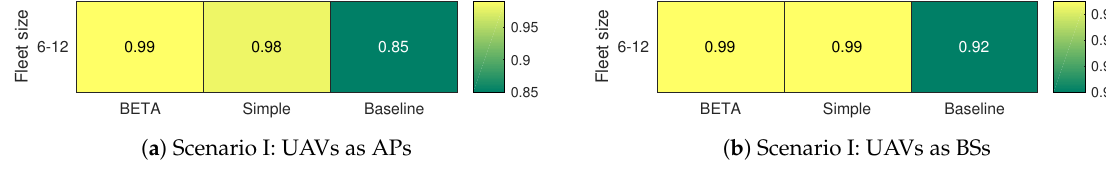
Figure 7. Approximation ratio ρ : optimal strategy vs. heuristic strategies for Scenario I.